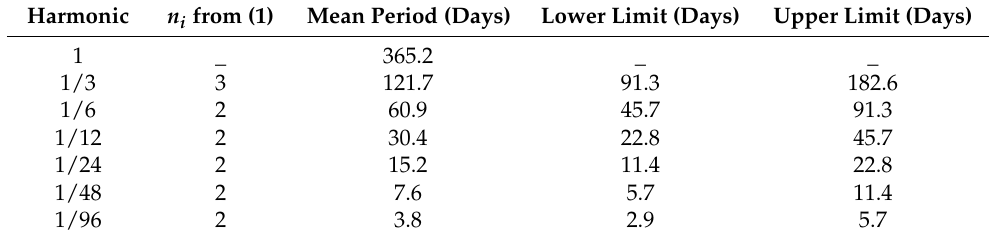
Table 1. Properties of observed or presumed harmonics and bandwidths.